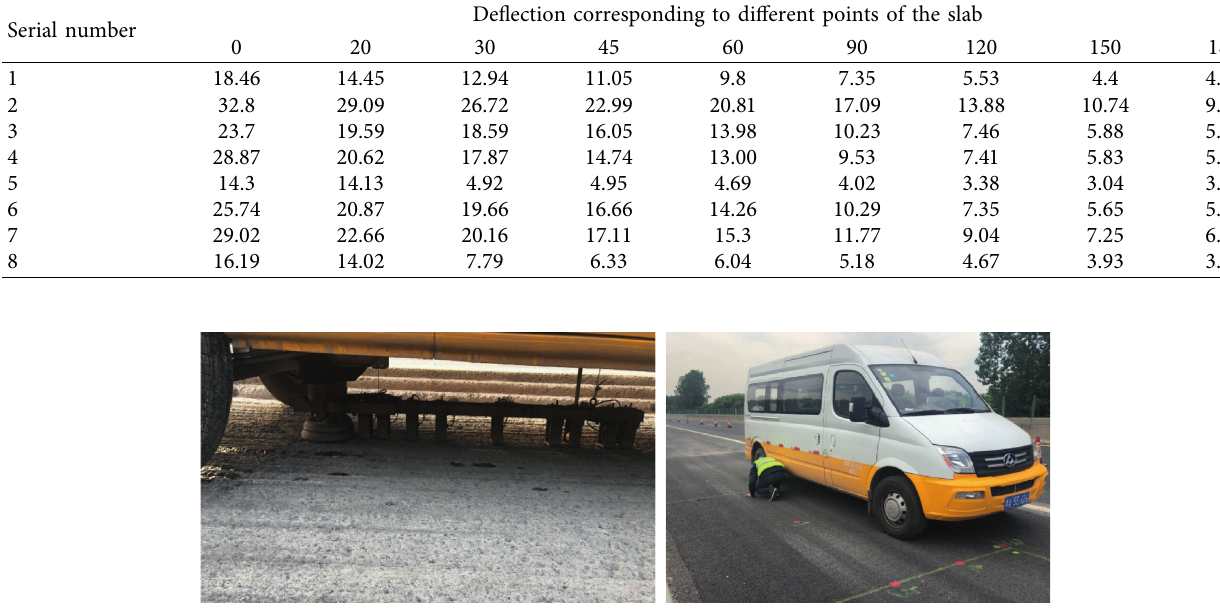
Figure 22: Field FWD detection.